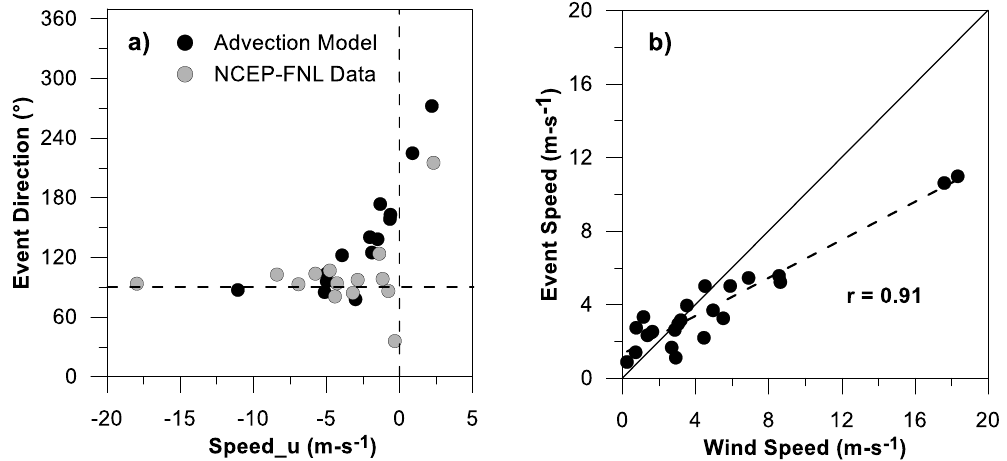
Figure 7. ( a ) Distribution of the wind speed and direction of the re-analysis data in contrast to the rainfall motion generated by the optical flow method for all precipitation events (negative event speed indicates that precipitation is moving west). ( b ) Hourly speed correlation generated by re-analysis data (X-axis) and the advection model (Y-axis) for the 11 events. Table 3. Correlation coe ffi cient r and average detection index for each rain event between images estimated by the advection model and observed by radar every 5 min. ID Event r